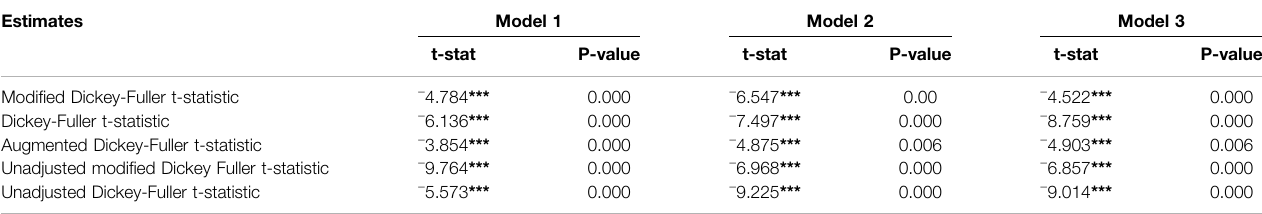
TABLE 3 | Panel cointegration analysis.